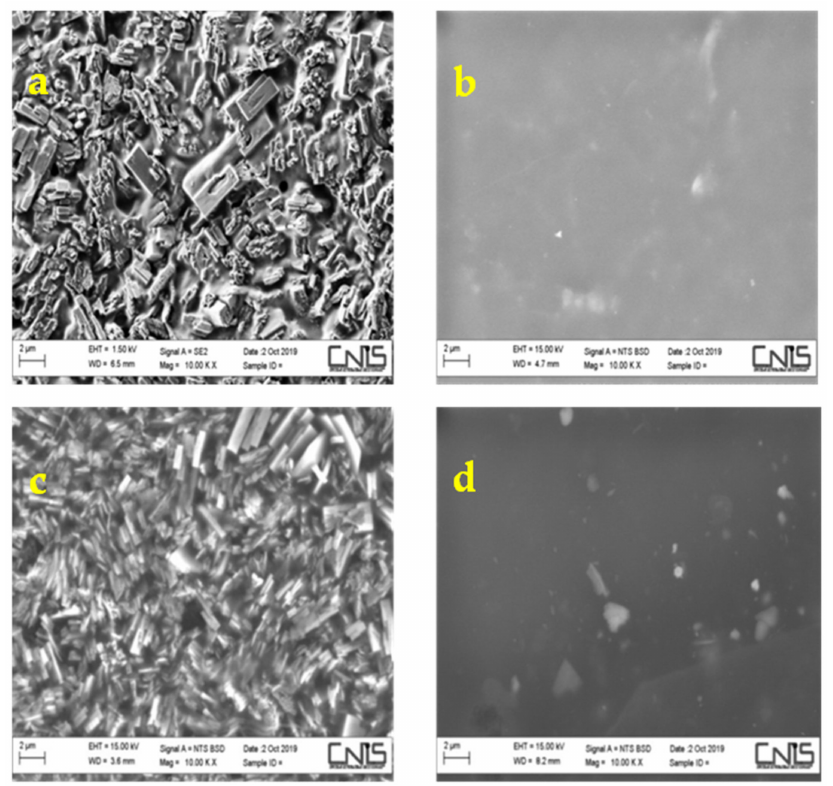
Figure 8. Top: SEM images of both M5 sides, one rich in perovskite ( a ) the other poor ( b ). Bottom: SEM images of both M10 sides, one rich in perovskite ( c ) the other poor ( d